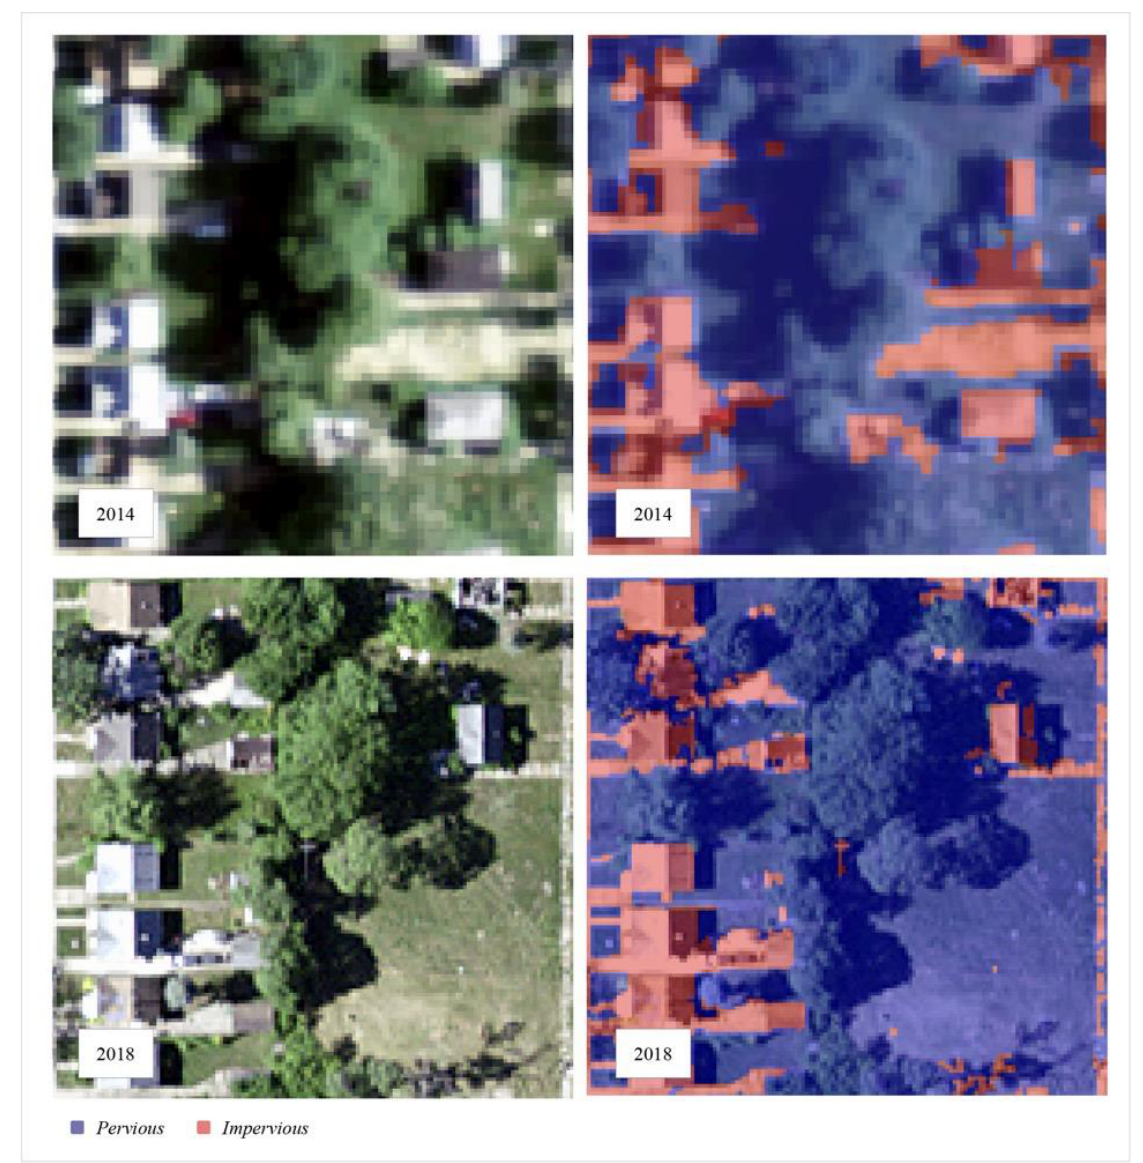
Figure 11. Batch GEOBIA, high demolition rate, Pulaski, Detroit.